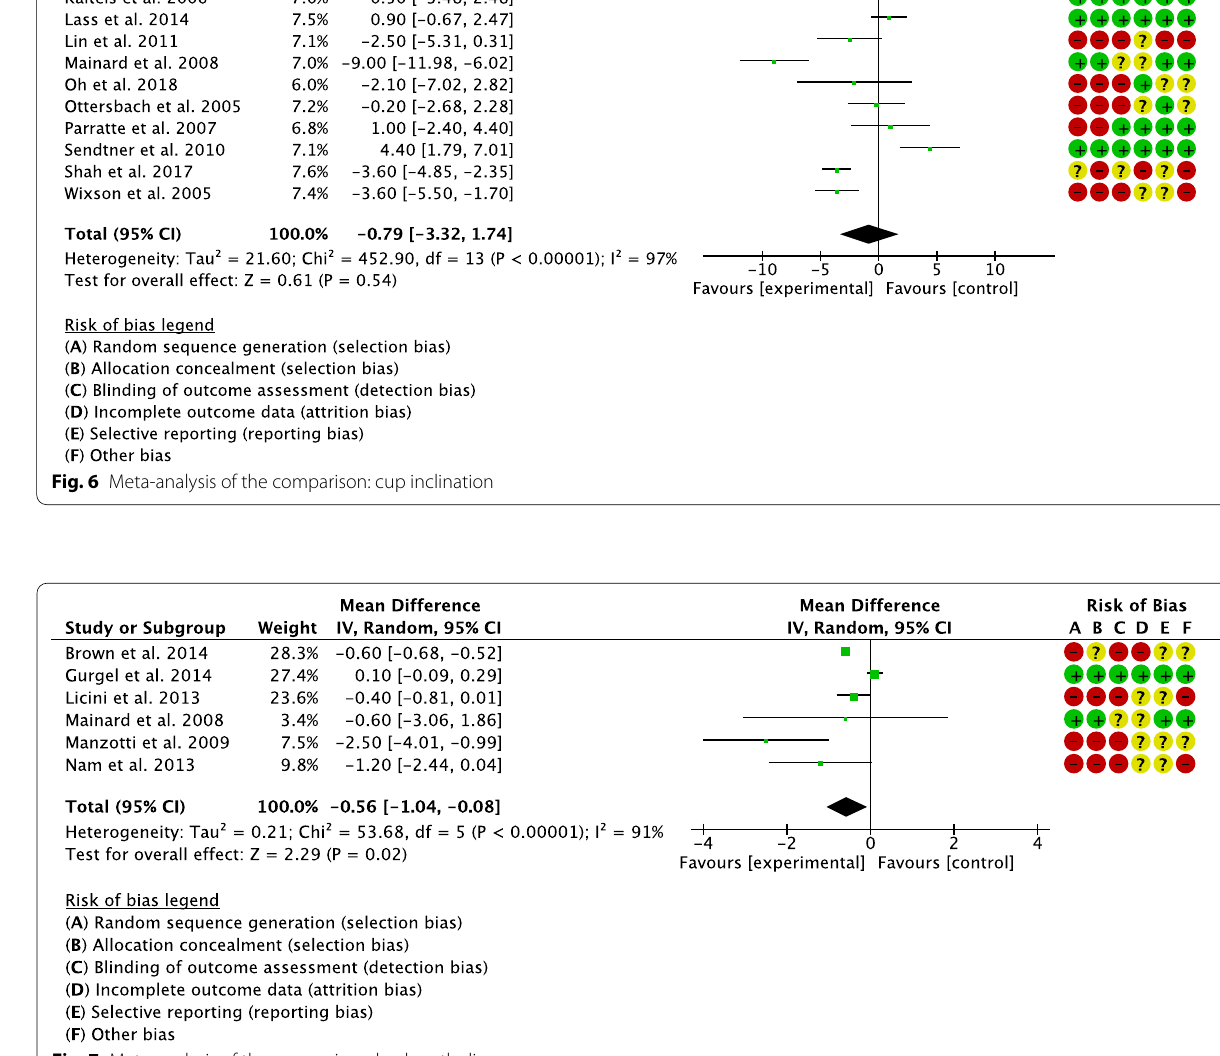
Fig. 7 Meta-analysis of the comparison: leg length